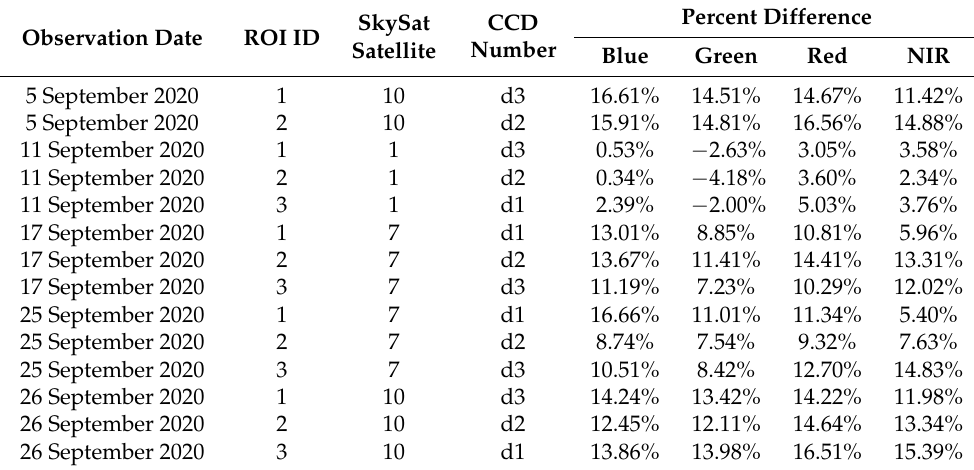
Table 7. Detailed absolute radiometric calibration results over the Libya